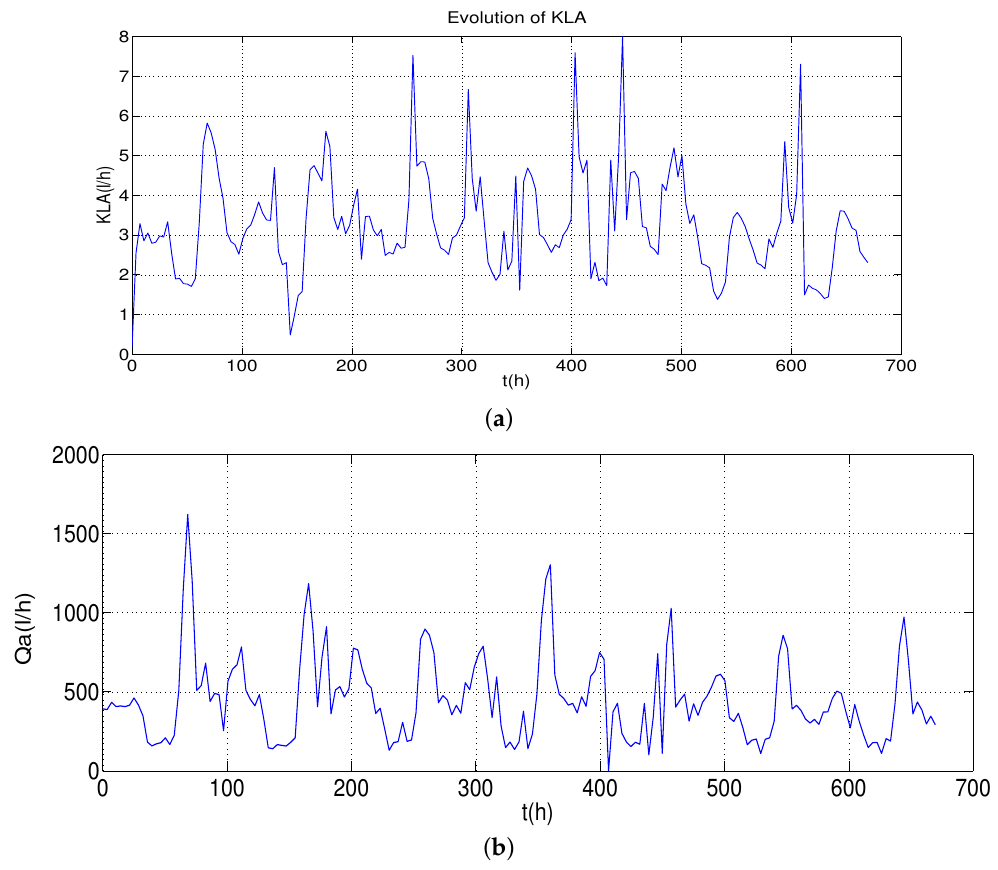
Figure 8. Manipulated variables with the proposed controller. ( a ) Oxygen transfer coefficient KL a , ( b ) Internal recycled flow Q a